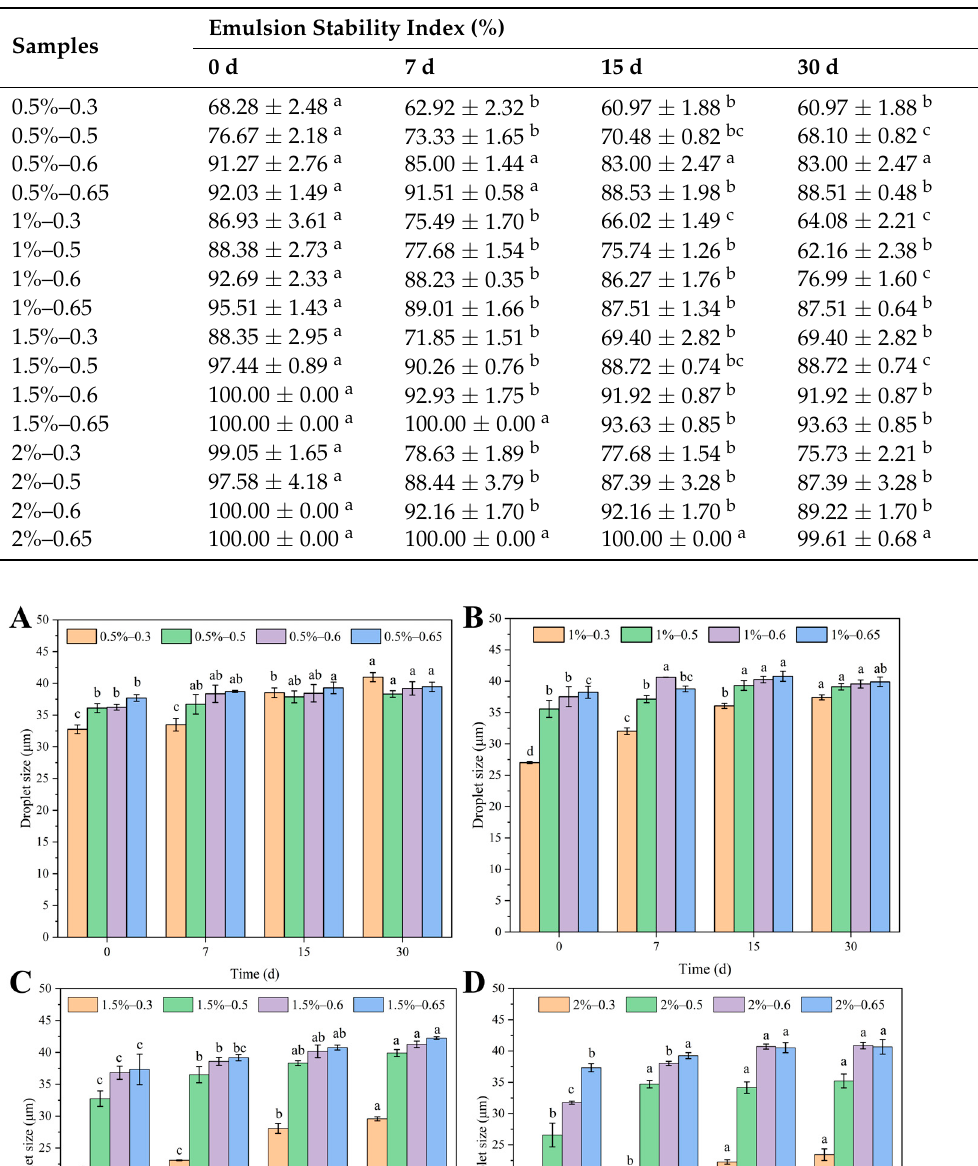
Table 1. Emulsion stability index of Pickering emulsions stabilized by LF–FD particles. The data are expressed as means ± SD ( n = 3). Different letters in the same line indicate significant differences ( p < 0.05).